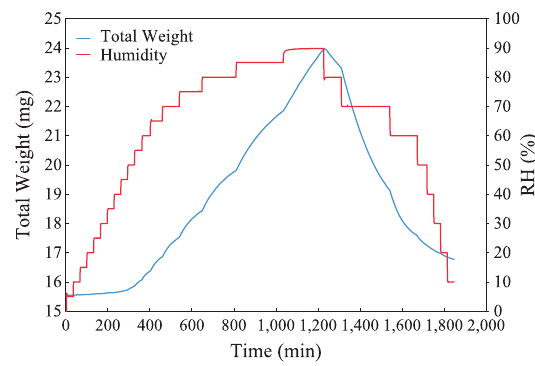
Fig. 1 Typical dynamic vapor sorption curve of the coffee creamer sample at 25 °C, with increase and decrease of the relative humidity at this temperature and the weight change of the material due to this relative humidity